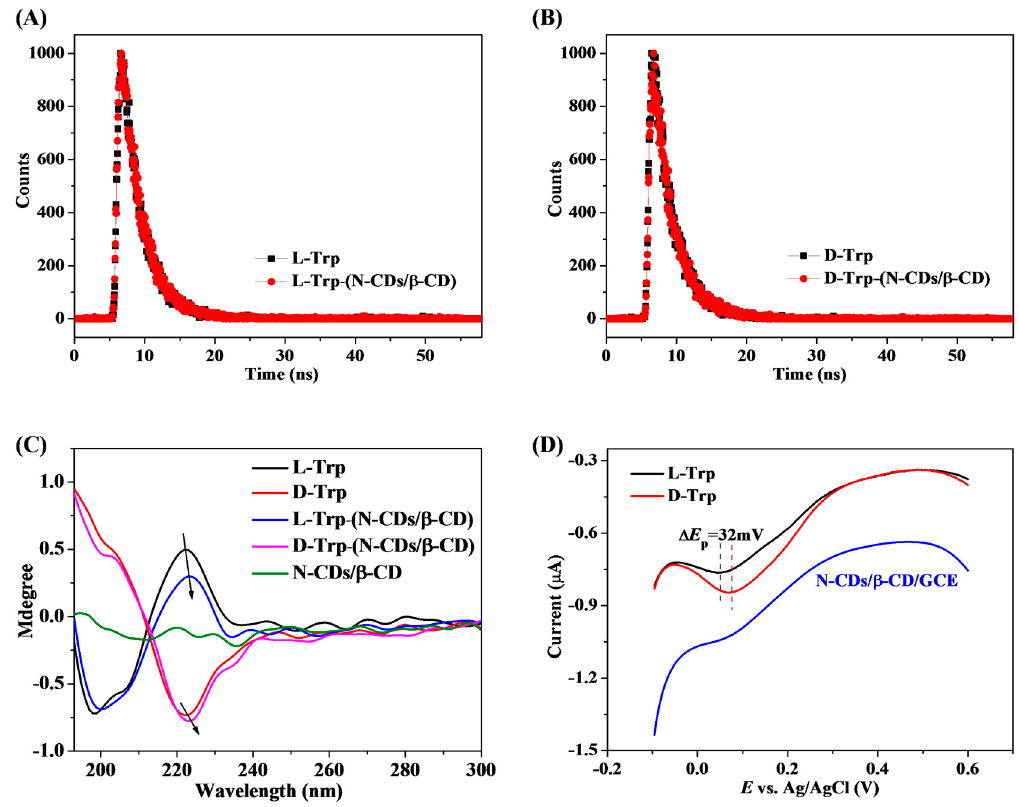
Figure 6. Fluorescence decay traces of L -Trp ( A ) and D -Trp ( B ) without and with N-CDs/ β -CD nanocomposites at λ ex/em = 278 nm/350 nm; ( C ) CD spectra of L -Trp, D -Trp, N-CDs/ β -CD nanocomposites, N-CDs/ β -CD– L -Trp and N-CDs/ β -CD– D -Trp; ( D ) DPVs responses of N-CDs/ β -CD/GCE for L -Trp and D -Trp.